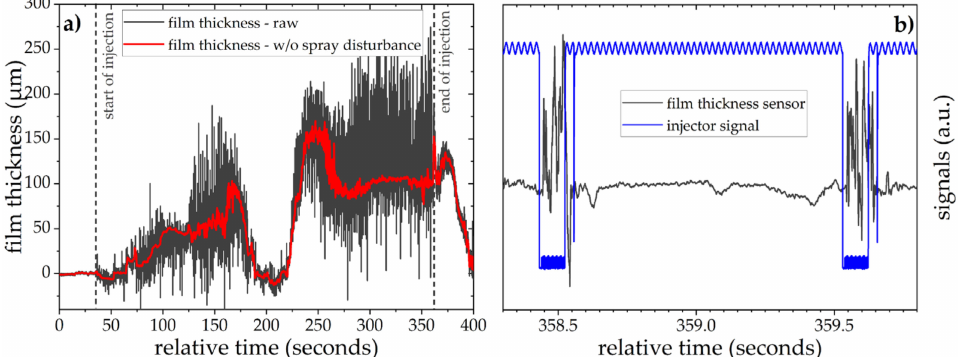
Figure 5. ( a ) Raw signal of the film thickness in black, the start and the end of AdBlue injection, and the film signal without spray disturbance in blue. ( b ) Section of film signal and the signal of the optocoupler for two arbitrary injection